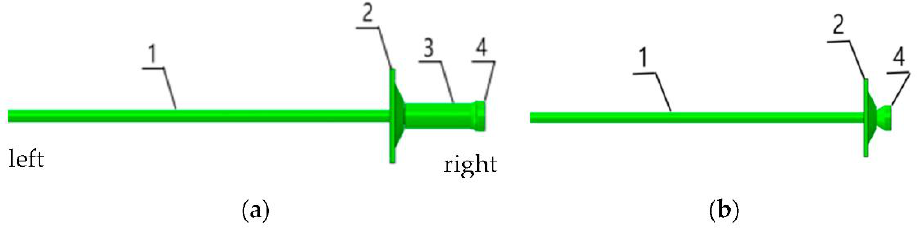
Figure 2. Anchor design drawings. ( a ) constant resistance energy-absorbing anti-scour anchor, ( b ) conventional anchors; 1: rod body; 2: tray; 3: anti-punch; 4: special-shaped nut.